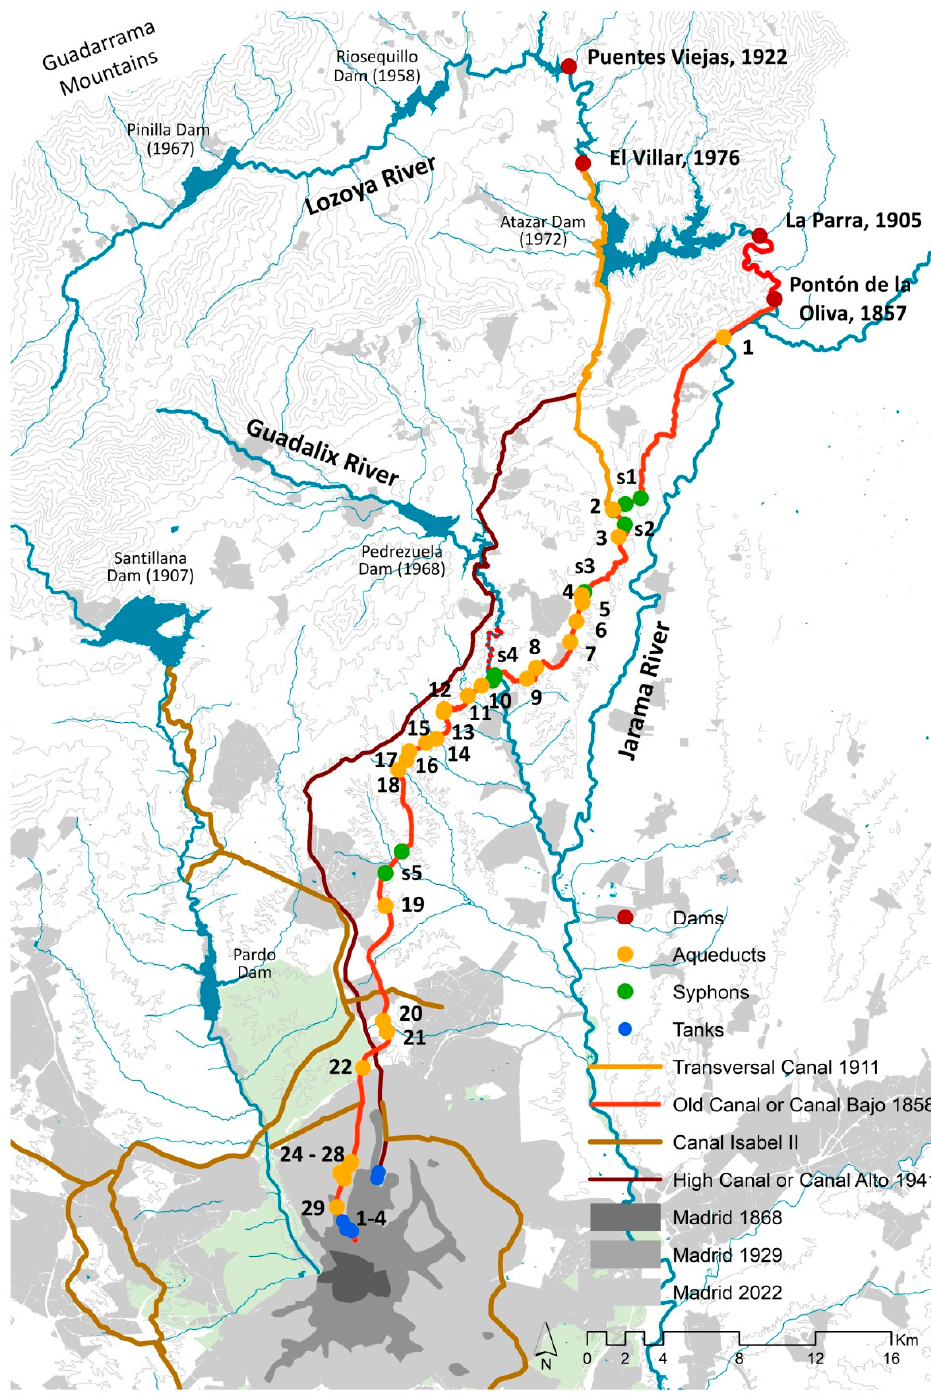
Figure 9. Canal de Isabel II as a whole system. Source: Created by the authors.